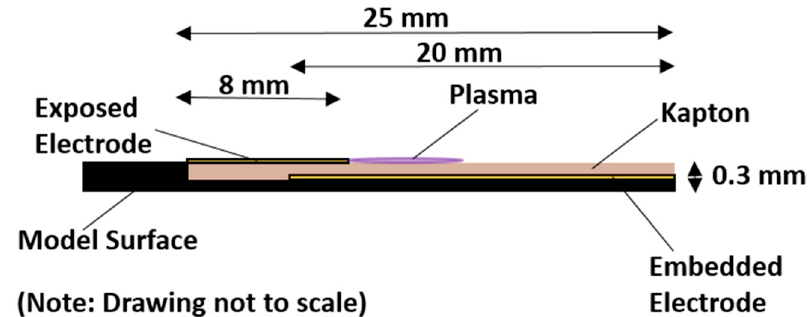
Figure 2. Schematic of the linear Single Dielectric Barrier Discharge (SDBD) plasma actuator.